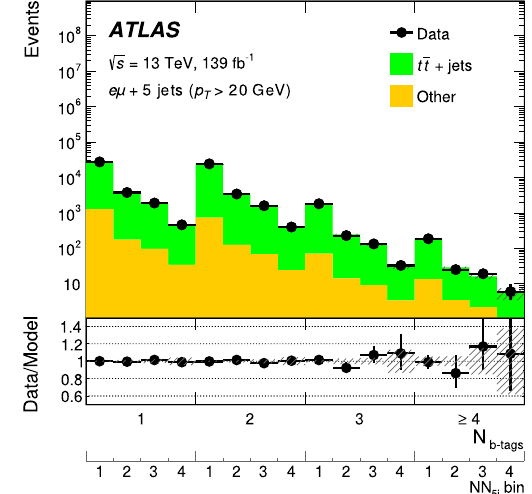
plate for the t ¯ t background is required to be identical in all b -jet regions. Good agreement between the data and estimated background confirms the invariance of the NN output with respect to the b -jet